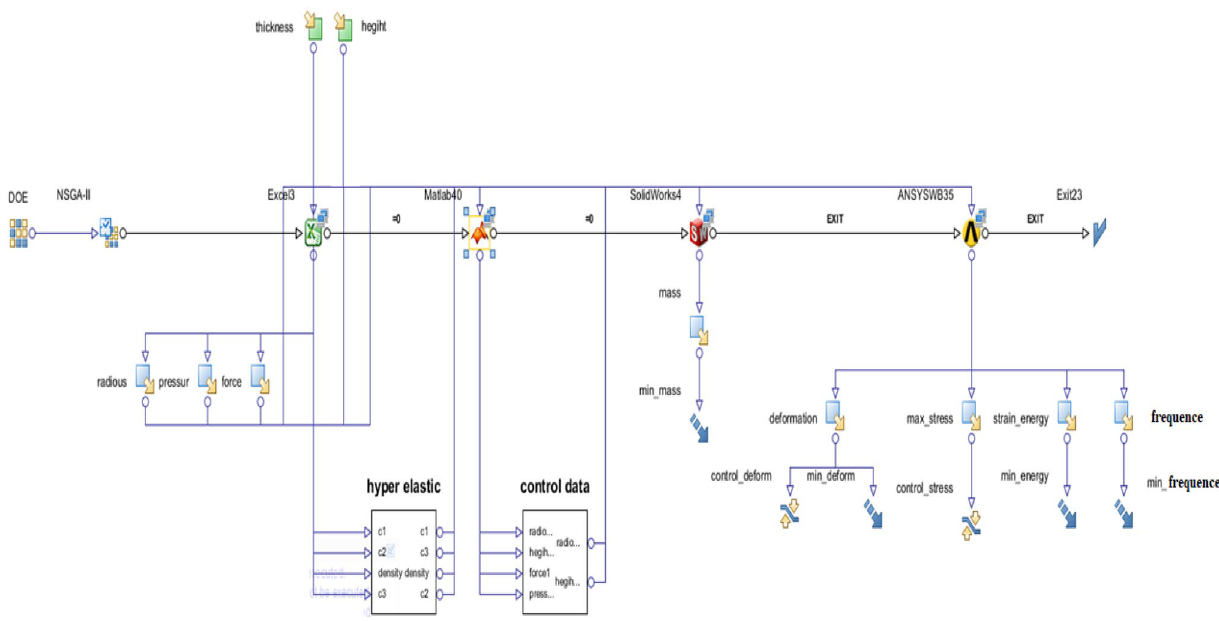
Fig. 31 Diagram block of automatic software for designing diaphragm tanks based on inversion